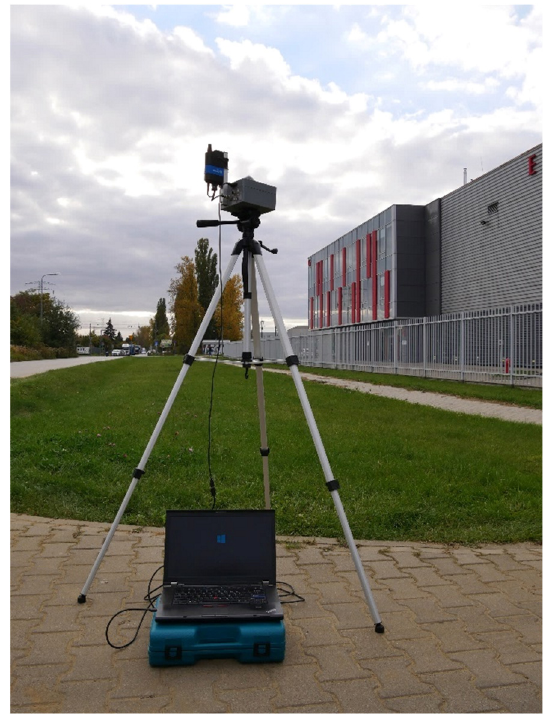
Figure 10. View of the reference station during measurement.